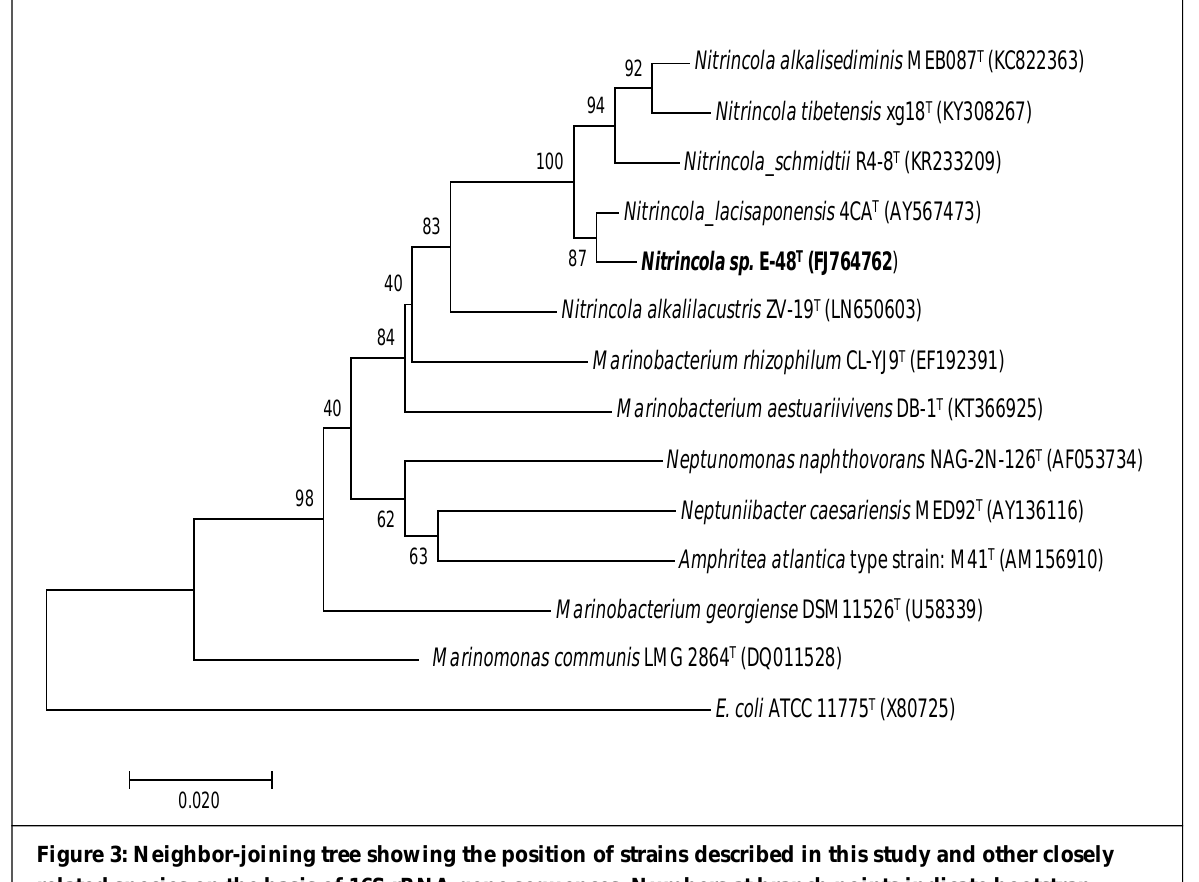
Figure 3: Neighbor-joining tree showing the position of strains described in this study and other closely related species on the basis of 16S rRNA gene sequences. Numbers at branch points indicate bootstrap confidence values (%) of 1000 resamplings. The bar represents 0.01 substitutions per nucleotide